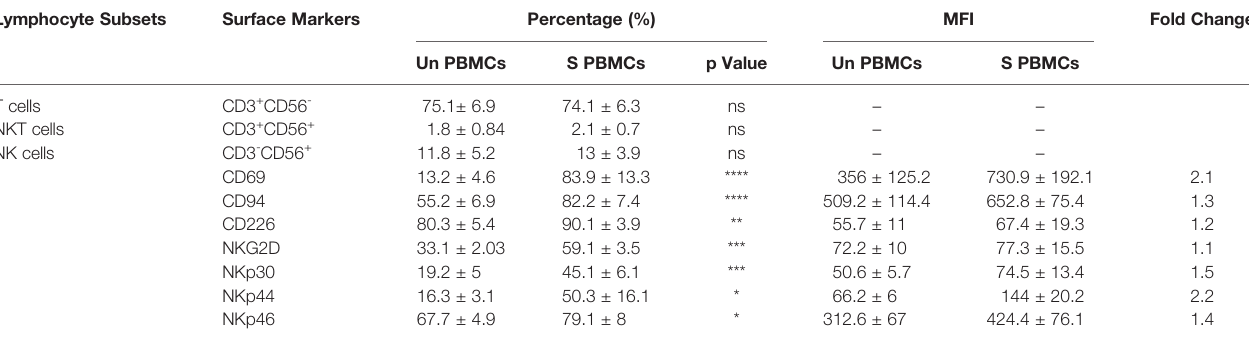
TABLE 1 | Frequency of T cells, NKT cells and NK cell subsets in peripheral blood mononuclear cells (PBMCs) isolated from healthy human donors and the expression of common NK cell activating receptors on unstimulated and TKD/IL-2 stimulated NK cells. Lymphocyte Subsets